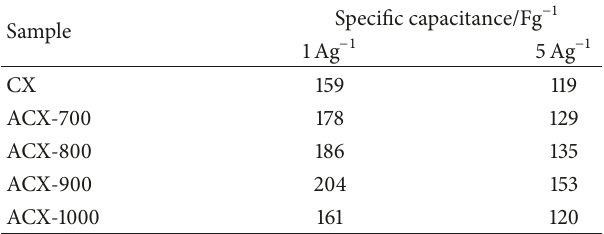
Table 5: Specific capacitance of the CX and ACX electrodes in 6 M KOH electrolyte obtained by the charge/discharge galvanostatic measurements at current densities 1Ag −1 and 5 Ag −1